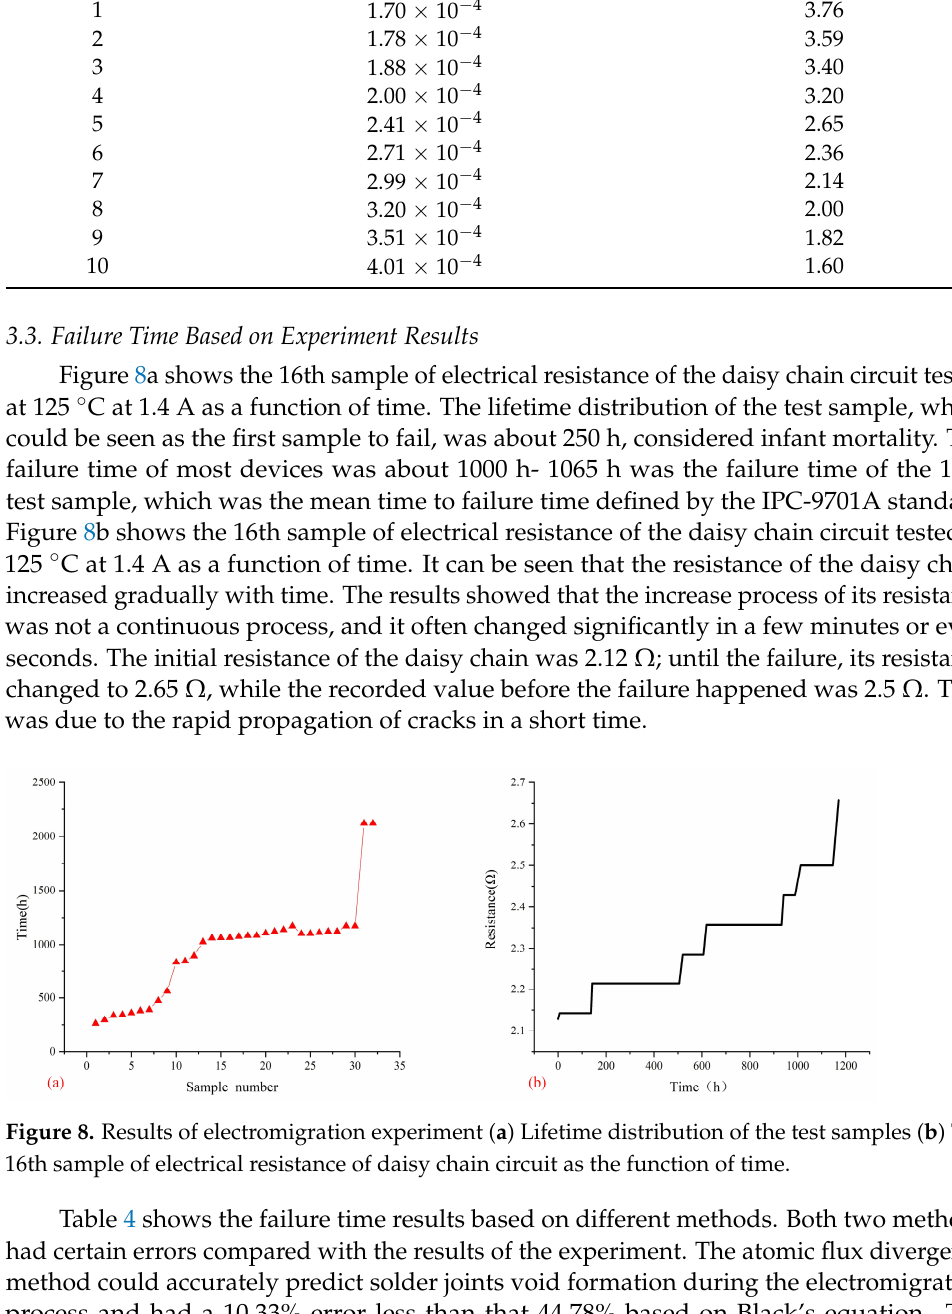
Table 3. Parameters of solder joints in each step.